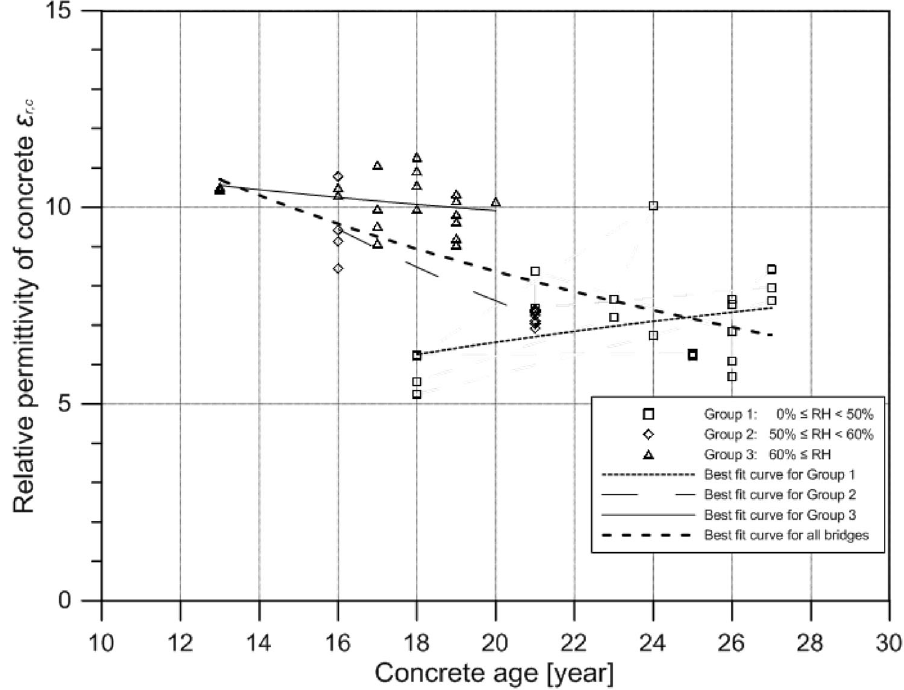
Fig. 9 Variation of relative permittivity of concrete in three bridge groups of similar relative humidity (RH) with concrete age: group 1 for RH lower than 50%, group 2 for RH between 50 and 60%, group 3 for RH equal to or greater than